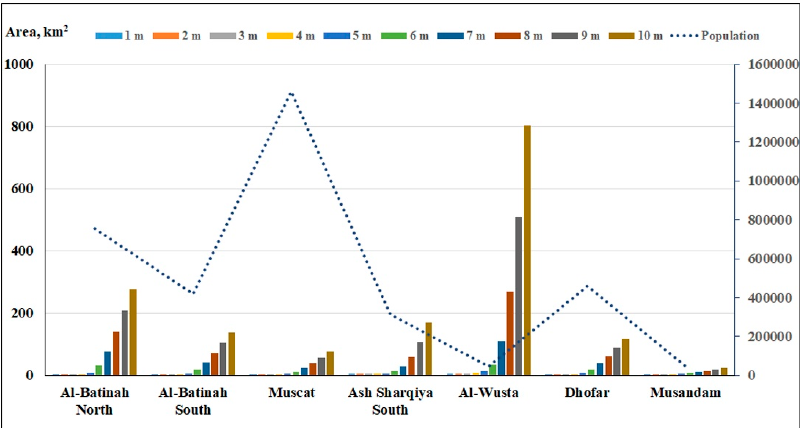
Table 2. The coastal elevations and inundation areas between 1 and 10 m along Oman coasts.